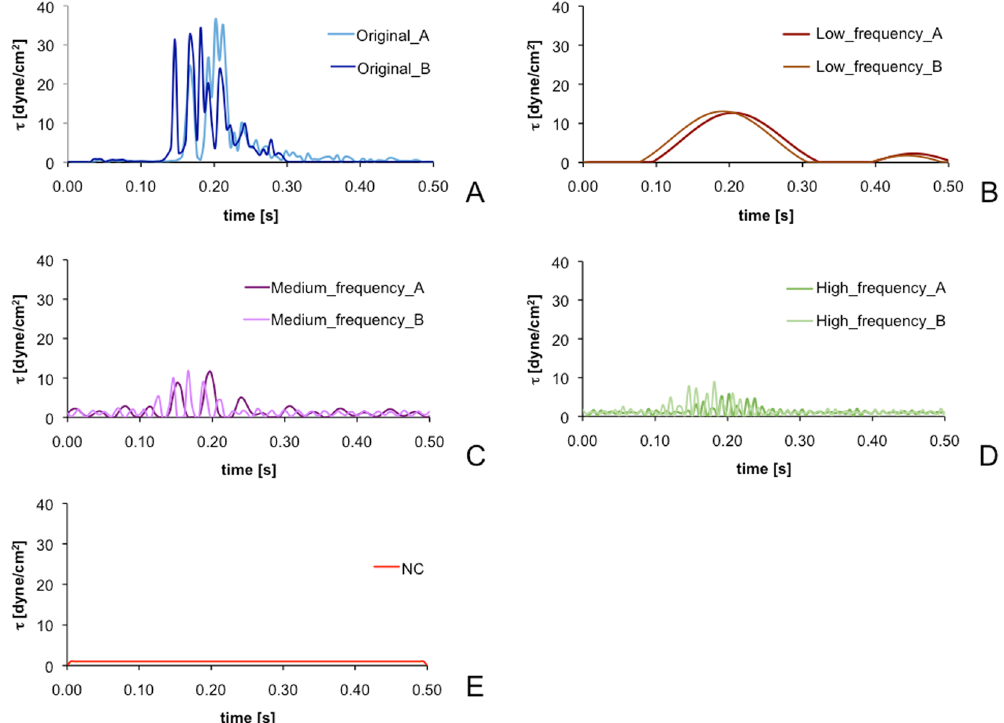
Figure 2. The test-curve data set: ( A ) Original curves; time-domain reconstructed curves corresponding to the ( B ) low- (Peak_1A and Peak_1B), ( C ) medium- (Peak_2A and Peak_3B) and ( D ) high-frequency (Peak_4A and Peak_4B) component elements of the power spectrum of Original_A and Original_B; ( E ) the time-constant and low-stress amplitude negative control (NC) curve.